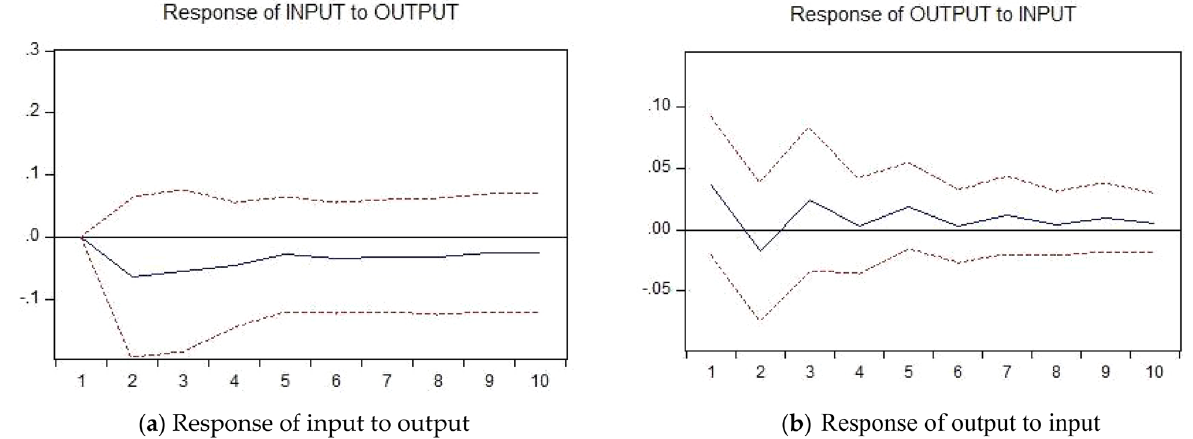
Figure 4. Impulse Response between input and output:( a )Response of input to output;( b )Response of output to